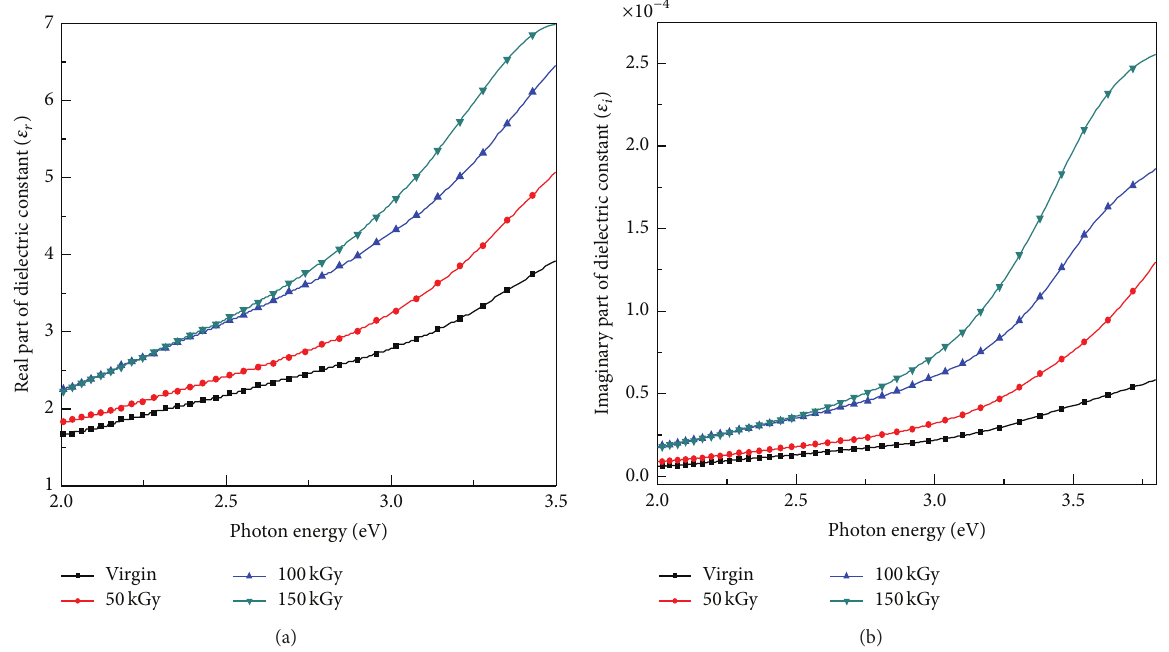
Figure 7: Variation of (a) real part of dielectric constant and (b) imaginary part of dielectric constant as a function of photon